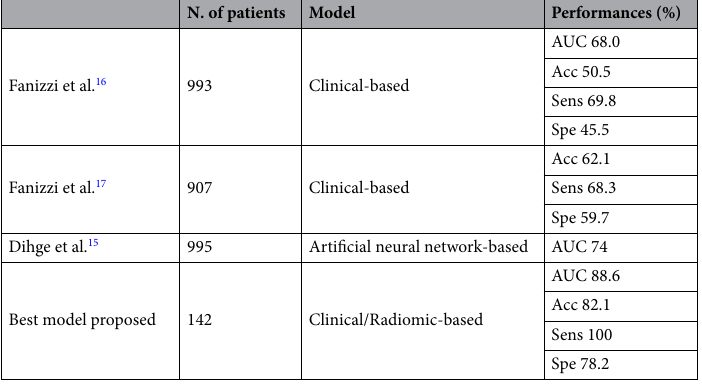
Table 3. Nodal status prediction in clinically negative breast cancer patients: comparison among the state-of- the-art models performances.